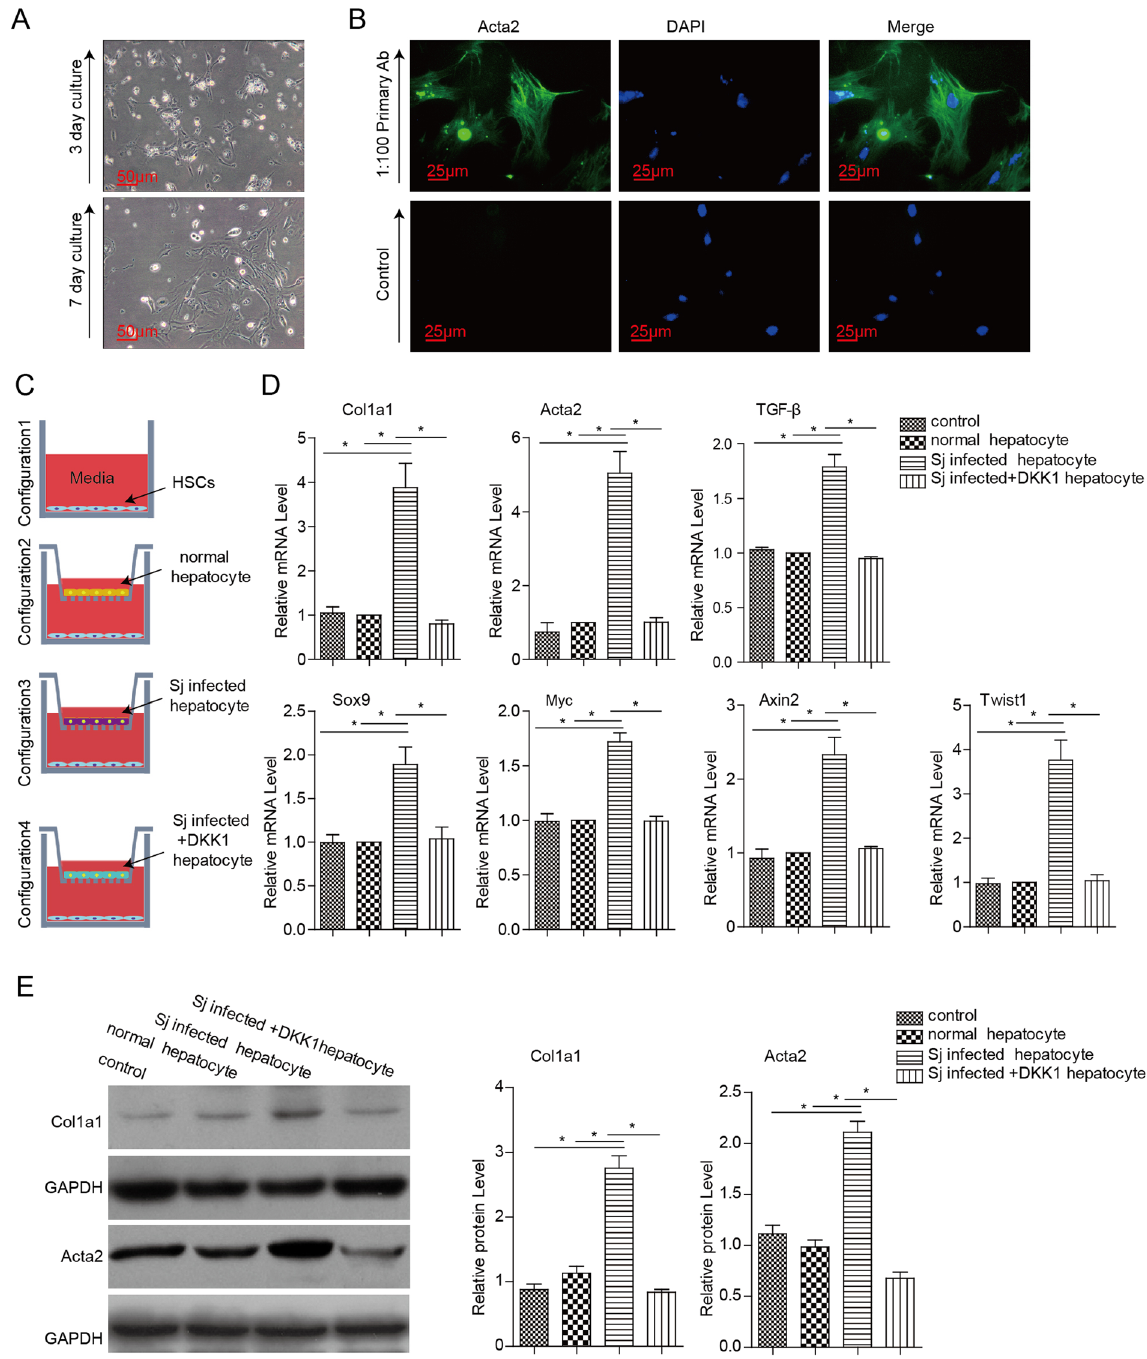
Figure 6. Primary hepatocytes isolated from S. japonicum -infected mice accelerate the activation of HSCs relying on Wnt signalling. The primary hepatocytes that were freshly isolated from normal mice and S. japonicum -infected mice with or without Lv-DKK1-EGFP administration were co-cultured with primary HSCs that had been cultured for 36 hours. ( A ) Phase contrast microscopic pictures of primary HSCs after 3 and 7 days of culture. ( B ) Immunofluorescence staining for α -SMA in isolated HSCs after 10 days of culture. ( C ) Pictures showing the pattern of the four-variable co-culture systems. ( D ) mRNA expression of Col1a1, α -SMA/Acta2 and TGF- β , as well as Wnt targets (Axin2, Myc, Sox9 and Twist1), was analysed after co-culture for 36 hours with hepatocytes by real-time PCR. ( E ) The protein expression of Col1a1 and α -SMA/Acta2 was analysed after co-culture for 36 hours with hepatocytes by western blotting. Scale bar, 50 μ m ( A ) and 25 μ m ( B ). Data represent the mean ± SEM; n = 3 ( * P <